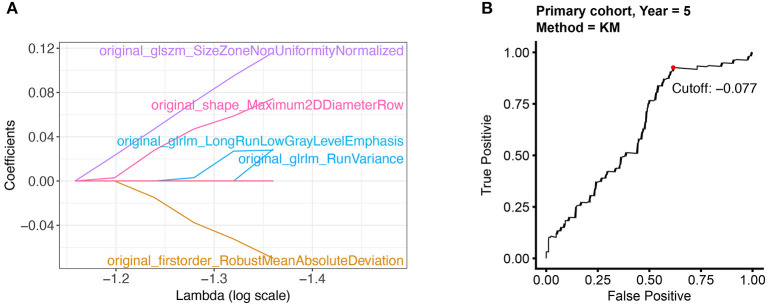
Selecting the radiomic features and the optimal cut-off point. (A) 5 radiomic features with non-zero coefficients were selected by using the LASSO algorithm. (B) The optimal cut-off point was determined by the time-dependent ROC curve.